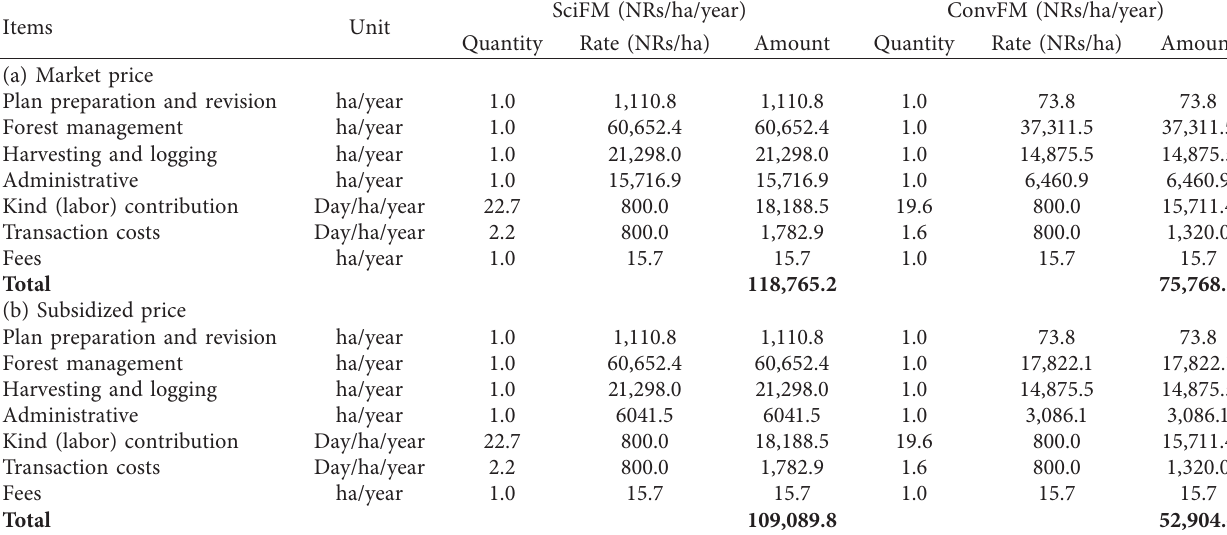
Table 6: Annual costs per unit area (ha) by the forest management system.